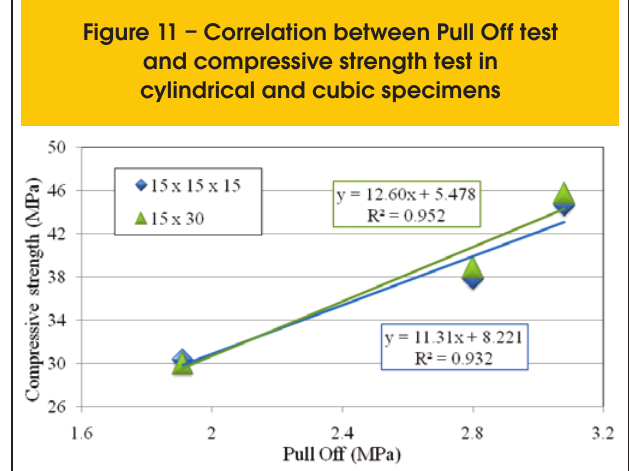
Figure 11 – Correlation between Pull Off test and compressive strength test in cylindrical and cubic